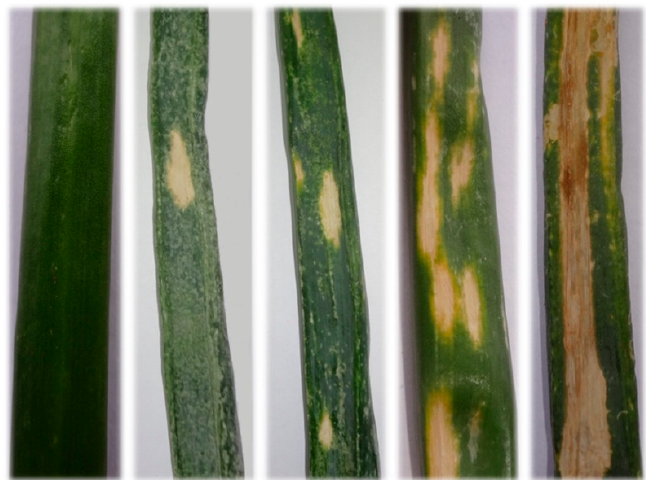
Figure 2. Typical Iris yellow spot (IYS) severity rating scale. IYS severity rating starting from left, 0 = no symptoms; 1 = 1–2 small lesions per leaf; 2 = more than 2 medium-sized lesions; 3 = lesions coalescing on more than 25% of the leaf tissue; 4 = more than 50% leaf is dead.